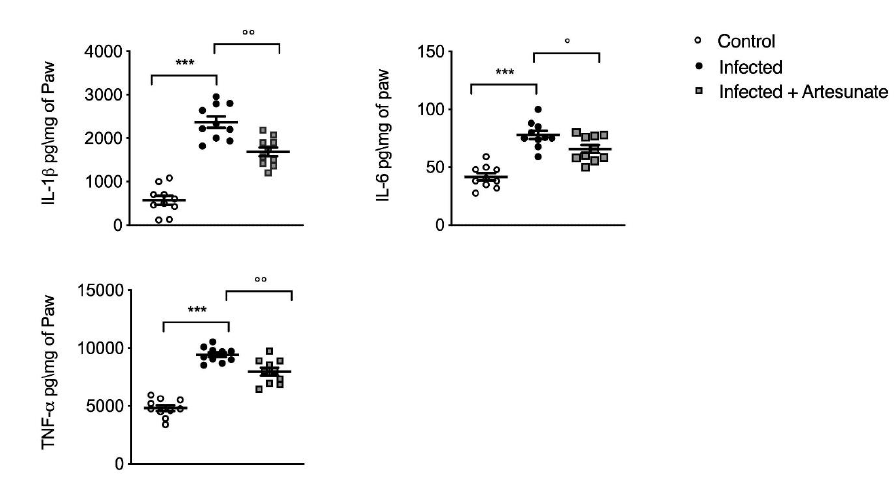
Figure 4. ELISA assay for interleukin (IL)-1 β , IL-6, and tumor necrosis factor alpha (TNF- α ) in paw tissue. Data are expressed as mean ± SEM from N = 10 mice for each group. *** p < 0.001 vs. control group; °° p < 0.01 vs. infected group; ° p < 0.05 vs. infected group.